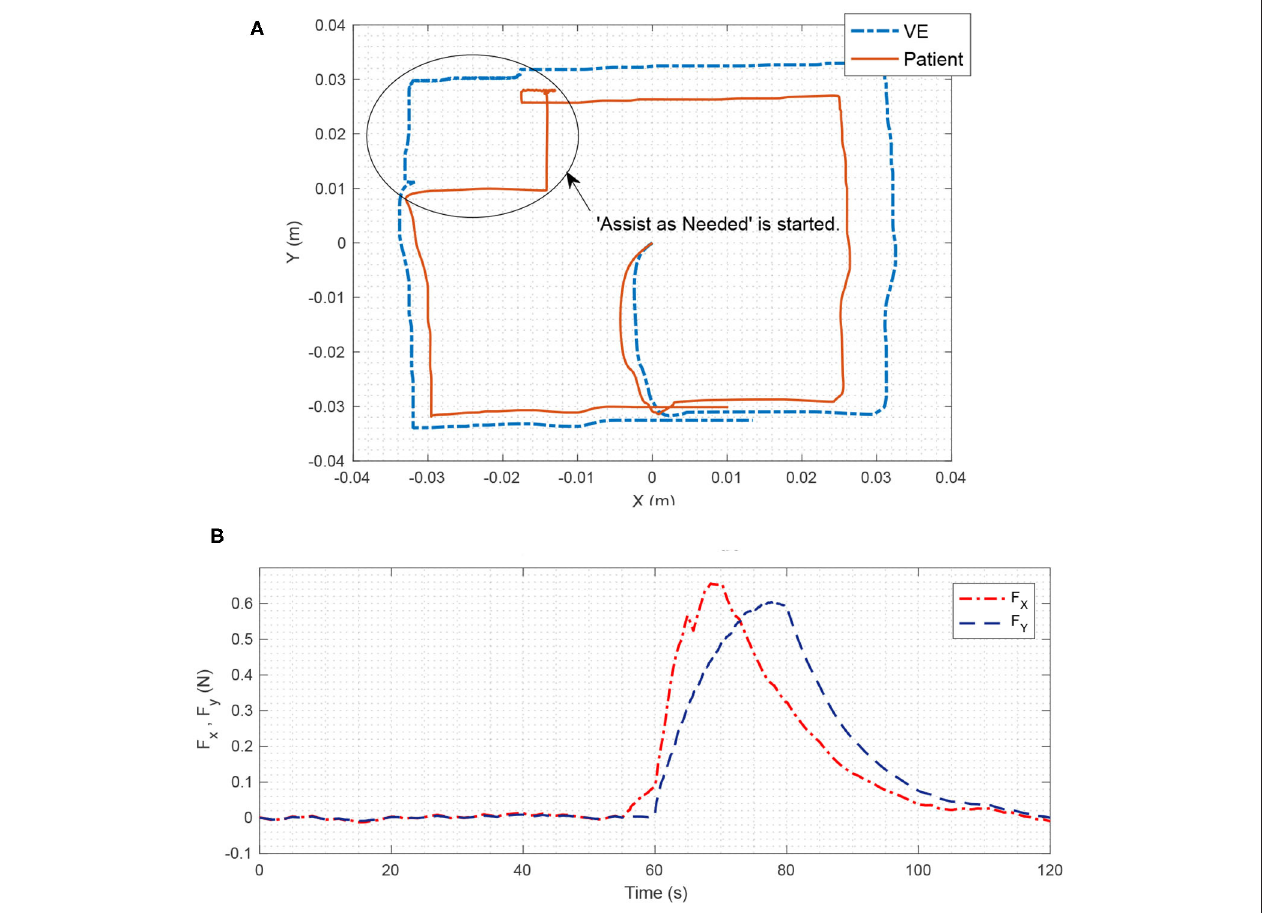
FIGURE 9 | (A) The 2D position of “Assist as Needed” is shown. (B) Assistive force in X and Y direction is illustrated. In the first 60 s of the therapy, teach and repeat method is applied. The path is recorded in the VE and is replied to the patient. The patient moves freely in the specified path, which is a square here. The VE also moves on the square. If the patient’s movement error is greater than the specified limit, Assist as Needed force is activated and attempts to return the patient’s robot position to the original square path with assistive force. As can be seen in part (B) the assistive force is almost zero before the 60th second; however, from about 60th second, it is activated in the X and Y directions and tries to return the patient to the desired path. Note that, in this figure, the absolute values of the assistive forces are shown to the reader for better understanding.